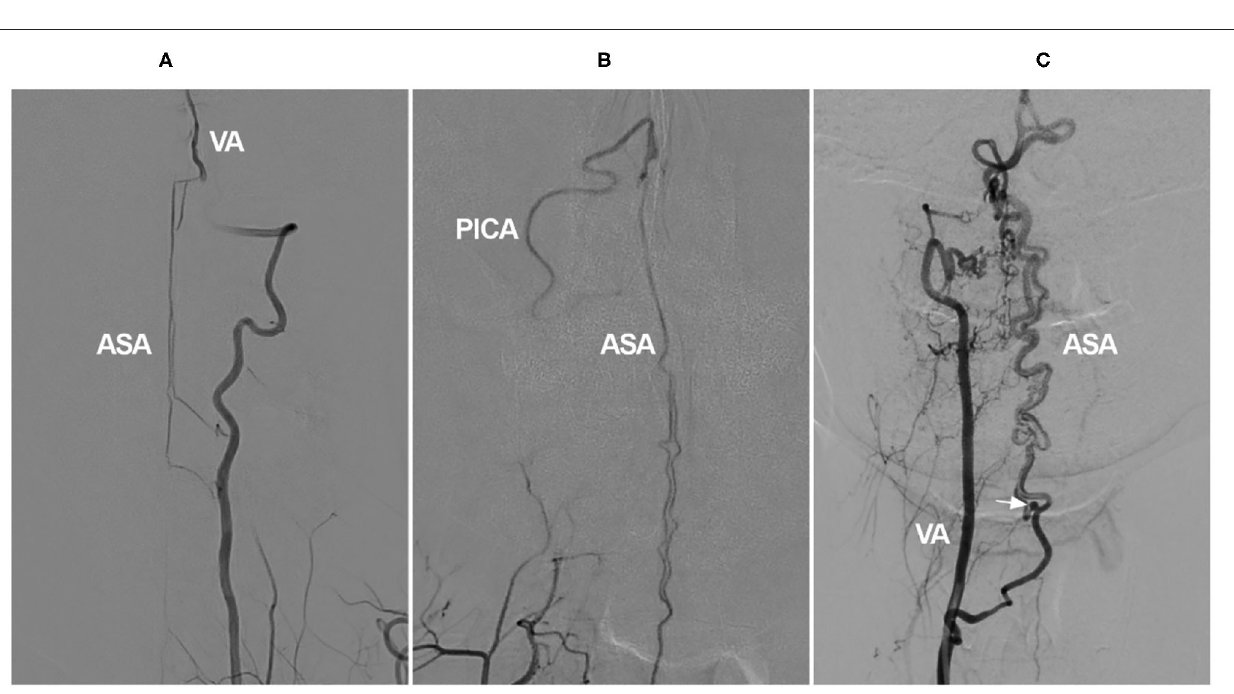
Frontiers in Neurology | www.frontiersin.org